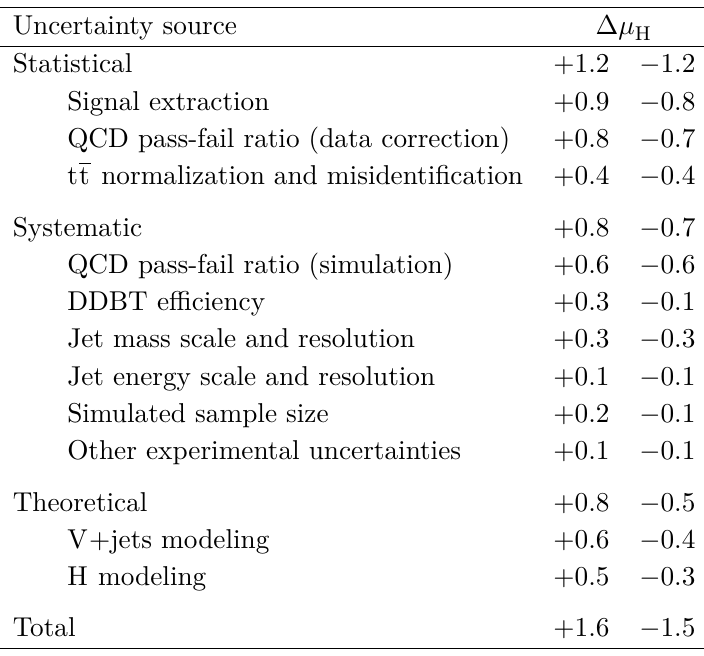
Table 2 . Major sources of uncertainty in the measurement of the signal strength µ based on H the HJ-MiNLO prediction, and their observed impact ( ∆ µ ) from a fit to the combined data set. H Decompositions of the statistical, systematic, and theoretical components of the total uncertainty are specified. The impact of each uncertainty is evaluated by computing the uncertainty excluding that source and subtracting it in quadrature from the total uncertainty. The sum in quadrature for each source does not in general equal the total uncertainty of each component because of correlations in the combined fit between nuisance parameters corresponding to different